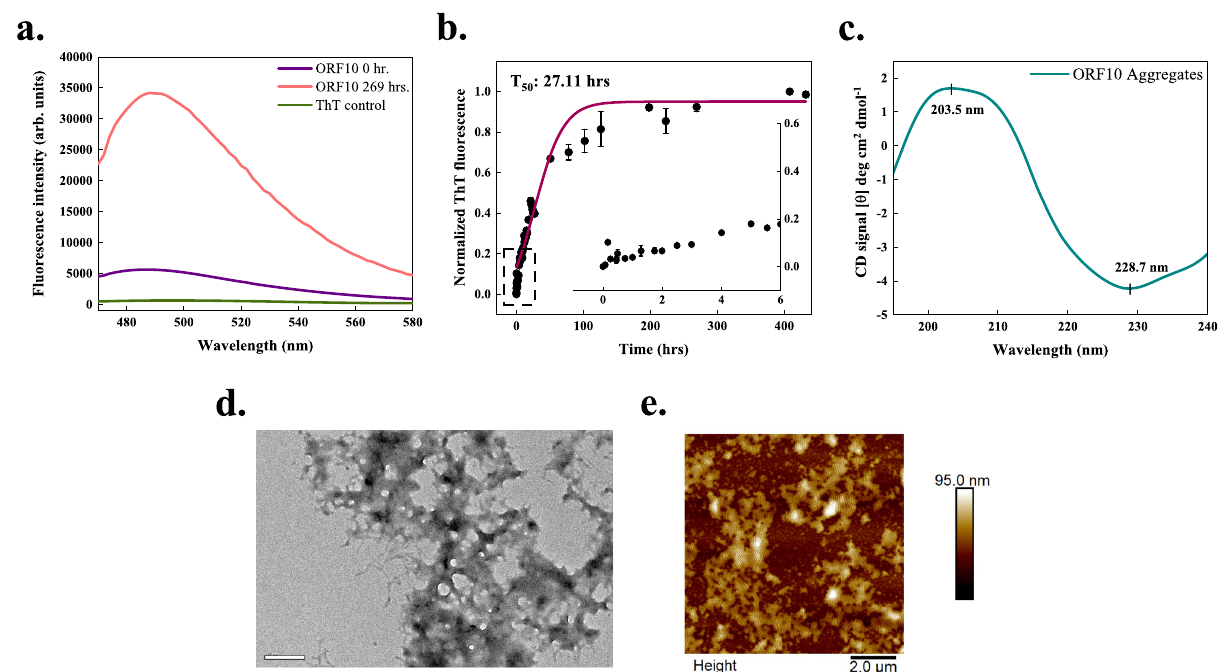
Fig.5|InvitroaggregationofORF10proteinofSARS-CoV-2.a ThT fl uorescence scan ( λ ex 440nm) indicates an increase of ~7-fold at λ max with ORF10 incubated sample. b Kinetics of ORF10 aggregation monitored using ThT fl uorescence. Each dotted symbol represents the average value of two technical replicates and error bar represents the SEM of these replicates. The wine-coloured line shows the sig- moidal fi ttingofdatapointsthatdeterminestheT 50 ofthisreactiontobe27.11±NC hrs. The aggregation kinetics shows a short lag phase that can be seen in the inset. c The secondary structure of 1mg/ml incubated sample (240h) studied using CD